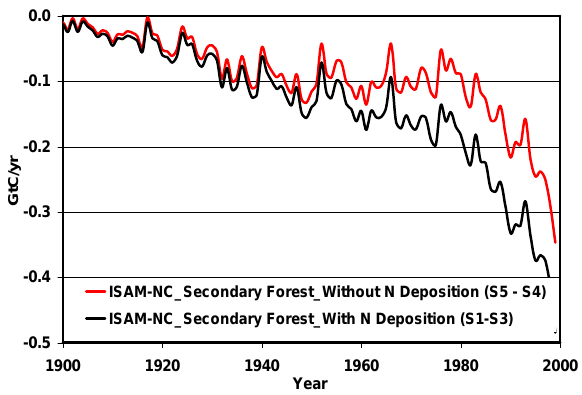
Figure 5. Latitudinal distribution of net carbon flux (gC/m2/yr) for the 1990s in secondary forests for ISAM-NC with N deposition (S1 minus S3), ISAM-NC without N deposition (S5 minus S4) and ISAM-C(S6 minus S7). In ISAM-NC experiments, C fluxes are affected by N dynamics, whereas in ISAM-C experiment C fluxes are not affected by N dynamics. Positive values represent net C release to the atmosphere and negative values represent net C storage in terrestrial biosphere.